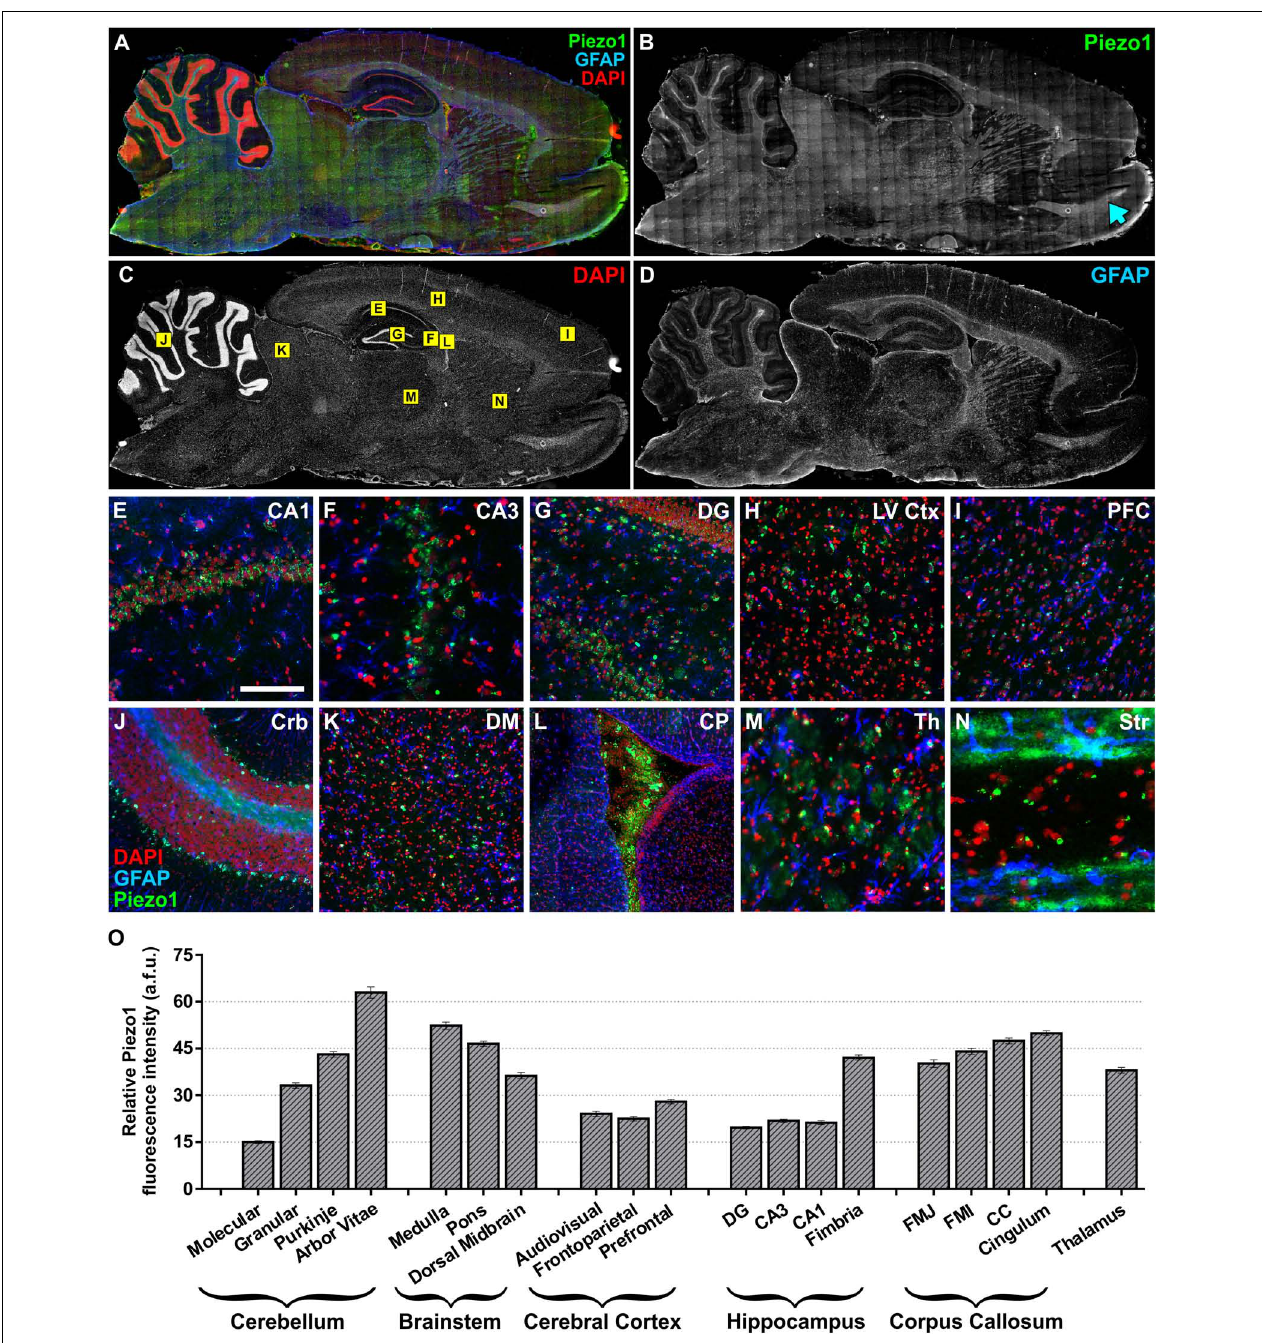
FIGURE 2 | Piezo1 channel expression in the adult rat brain. (A) The brains of adult (12 month) Fisher rats were sectioned in the sagittal plane (lateral –1.9 mm) and stained for (B) Piezo1 (N-terminal antibody), (C) DAPI, and (D) GFAP ( n = 5). Images were captured using a 20 × magnification objective on an Axio Scan.Z1 slide scanner (Zeiss, Germany) and montaged in ZEN software. 20 × magnification images of the hippocampal (E) CA1 (scale bar = 150 µ m), (F) CA3 and (G) dentate gyrus (DG) show that Piezo1 expression is greater in pyramidal and granule neurons compared to GFAP-positive astrocytes. In the cerebral cortex, (H) layer V pyramidal neurons (LV Ctx) appear to express more Piezo1 channels than (I) prefrontal cortical (PFC) neurons. In the cerebellum (J) , Purkinje neuron cell bodies and axons (arbor vitae) express higher levels of Piezo1 compared to neurons in the granule and molecular cell layers. (K) The dorsal midbrain (DM) expresses moderate levels of Piezo1, whereas (L) epithelial cells of the choroid plexus (CP) express greater amounts of Piezo1 protein. It was also noted that white matter tracts in (M) the thalamus (Th) and (N) striatum (Str) express more Piezo1 than gray matter areas of these brain regions. The areas depicted in images (E–N) are shown as yellow boxes in (C) . Relative fluorescence intensity (arbitrary fluorescence units, a.f.u.) of Piezo1 staining in each brain region was quantified (O) . Axonal tracts including the cerebellar arbor vitae, hippocampal fimbriae, cingulum and corpus callosum, as well as the medulla and pons of the brainstem, had the highest expression of Piezo1